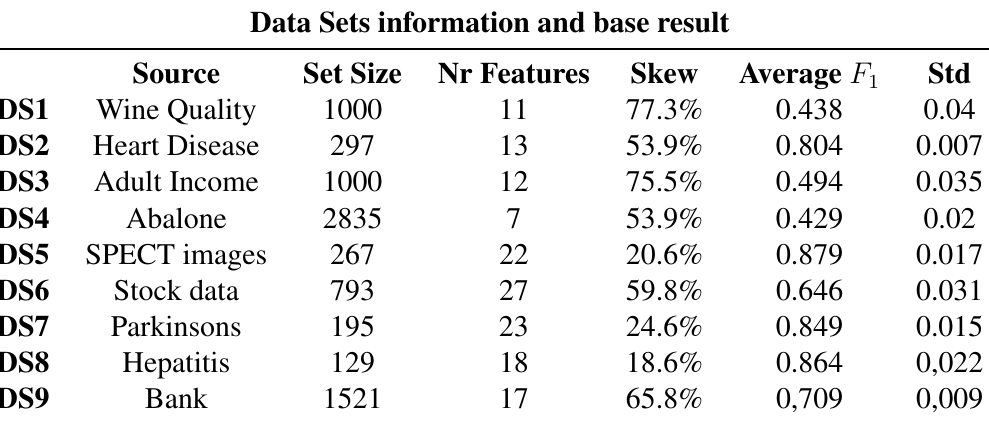
Table 1: Datasets used in the experiments. Skew is calculated as the ratio of negative classes. Data Sets information and base